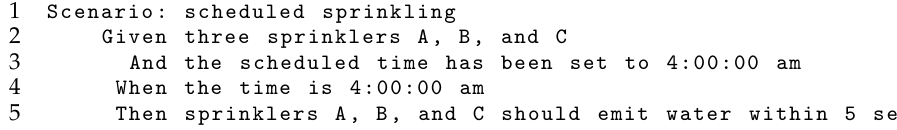
Figure 10. Scheduled sprinkling with behave : lumping three concurrent behaviors into one step.